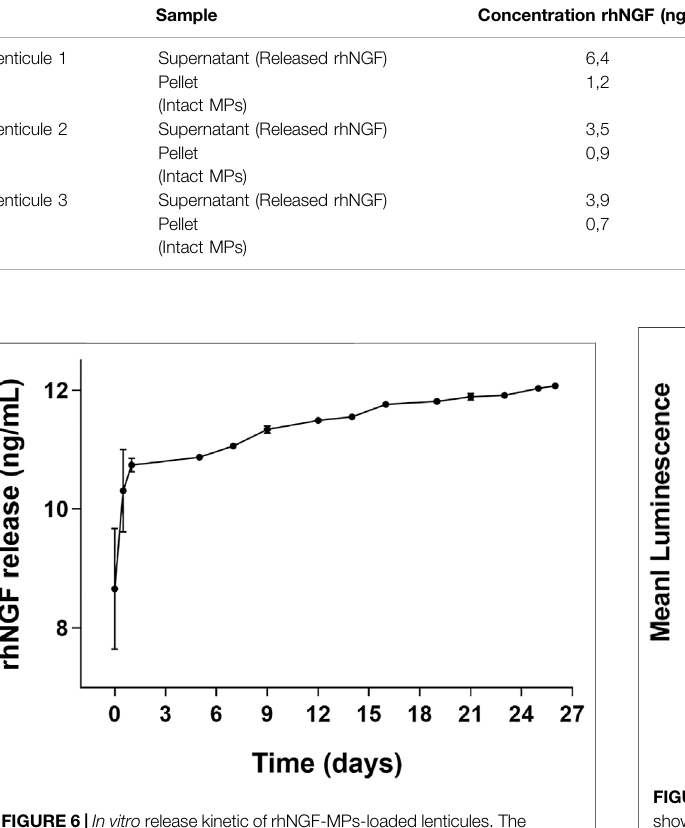
FIGURE 6 | In vitro release kinetic of rhNGF-MPs-loaded lenticules. The graphshowsthecumulativereleaseofrhNGFfromtheMPspreviouslyloaded to decellularized lenticule. Samples are collected every 2 or 3 days and the experiment was maintained for 25 days. Data are reported as mean ± SD ( n = 4).